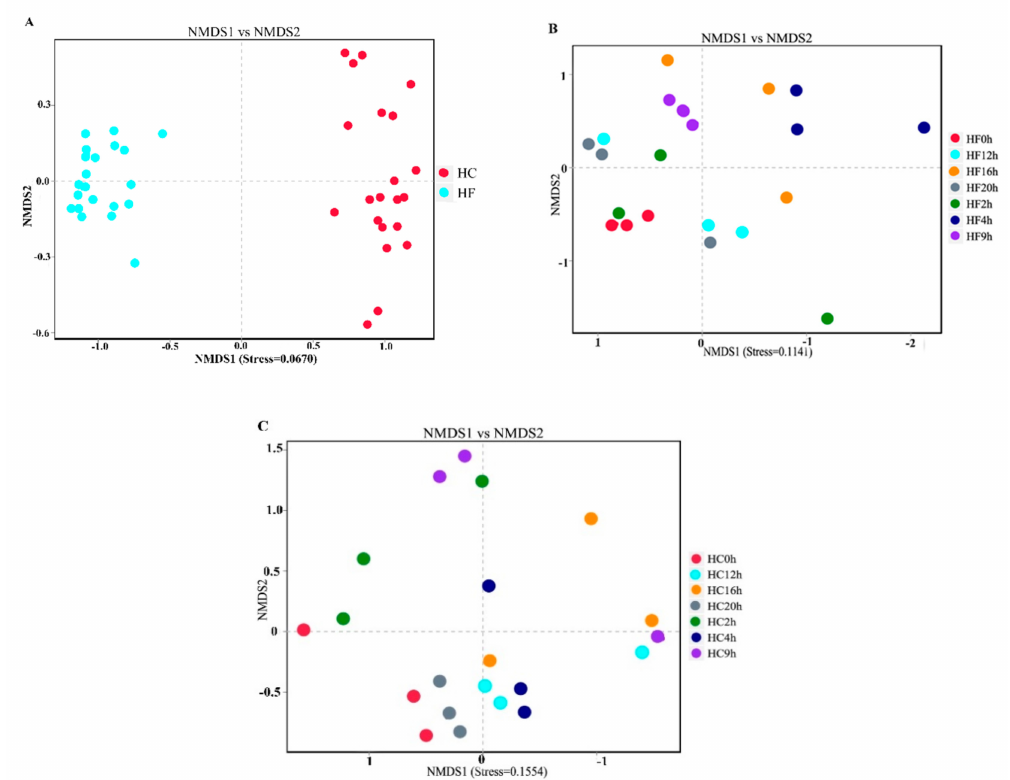
Figure 2. Nonmetric multidimensional scaling (NMDS) analysis. ( A ) HF and HC groups. ( B ) HF group. ( C ) HC group. Each point in the graph represents one sample, and same colors represent same groups. The distance between points represents the level of difference. Stress lower than 0.2 indicates that the NMDS analysis is reliable. The closer the samples in the graph, the higher their similarity.